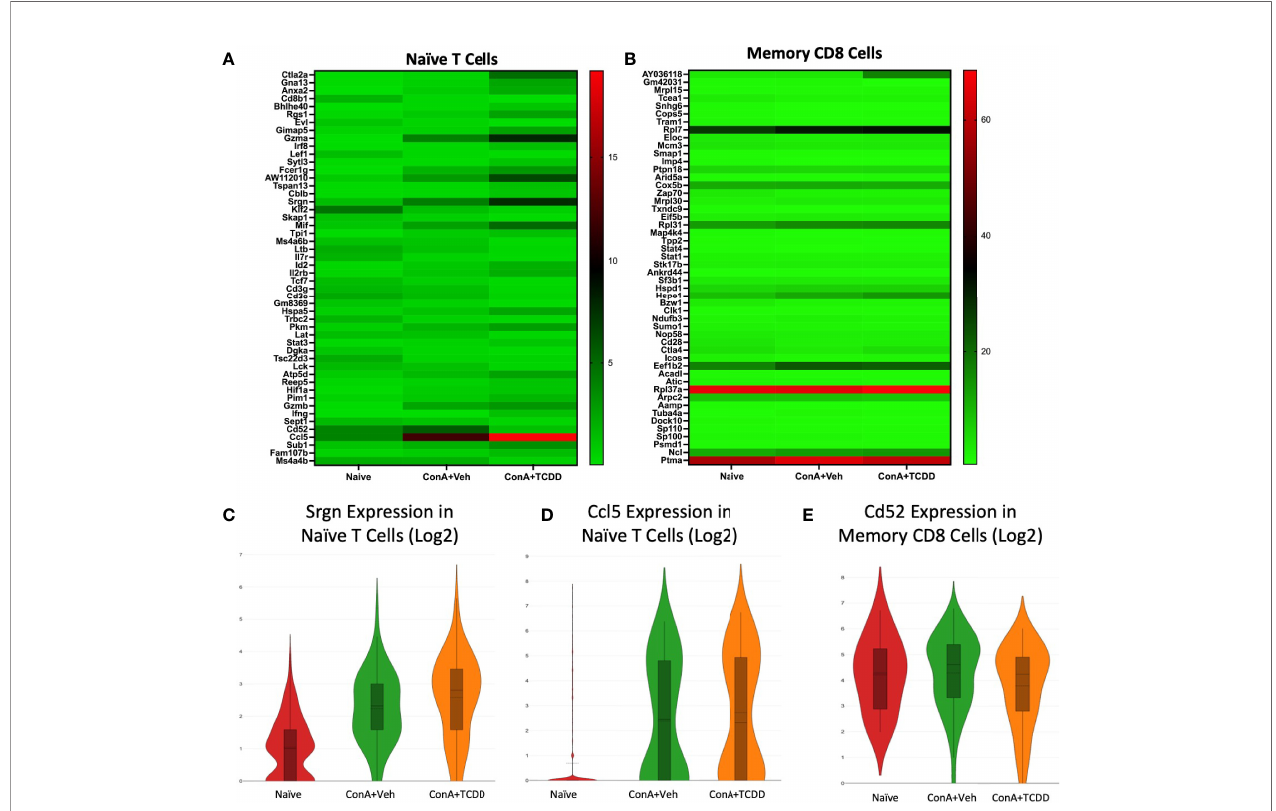
FIGURE 6 | Srgn, Ccl5, and Cd52 identi fi ed as dysregulated genes of interest in Naïve T Cell and Memory CD8+ T Cell clusters. C57/BL6 mice were injected with ConA followed by vehicle or TCDD 1 hour later as described in Figure 1 legend. Liver in fi ltrating cells were isolated and scRNA-seq was performed as described in Methods. Heatmaps consisting of the top 50 differential genes per treatment were generated using Loupe Browser. Heatmaps of differentially expressed genes from (A) Naïve T cells and (B) Memory CD8+ T cells. (C – E) Violin plot of Log2 expression of target